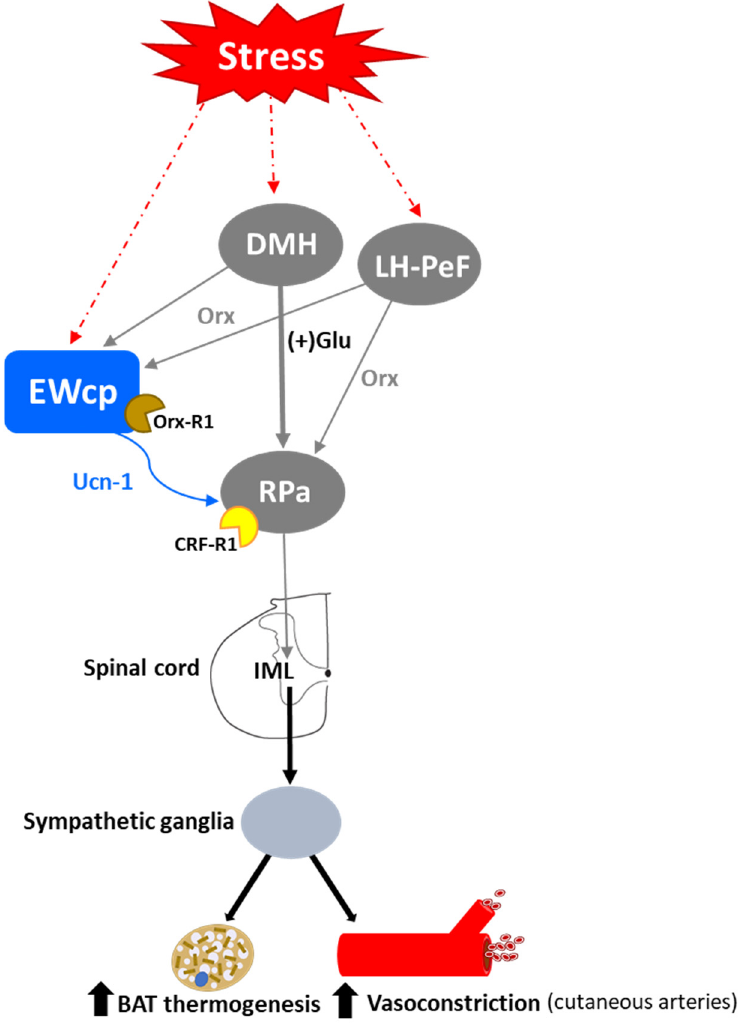
Figure 6. Connections of EWcp with the circuit responsible for stress-induced hyperthermia. Acti- vation of presympathetic neurons in RPa, driven by glutamatergic inputs from DMH, is required for BAT sympathetic nerve activation and subsequent stress-induced hyperthermia. EWcp receives inputs from DMH and projects to RPa, which expresses CRF-R1, receives Ucn-1 innervation (presumably from EWcp), and becomes activated by central administration of Ucn-1. Moreover, stressors that induce hyperthermia activate Orx neurons in LH-PeF and Ucn-1 neurons in EWcp. Orx neurons directly project to RPa and EWcp, which contain Orx-R1. EWcp provides output to brainstem presympathetic regions involved in the sympathetic control of BAT and also the tail artery, which is a key element for cutaneous vasoconstriction in rodents. For terms, see the list of abbrevi- ations.